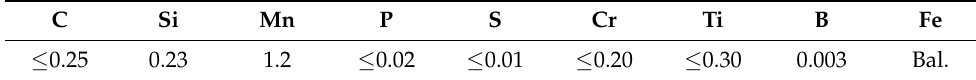
Table 1. Chemical composition of 22MnB5 steel (wt %) [19].